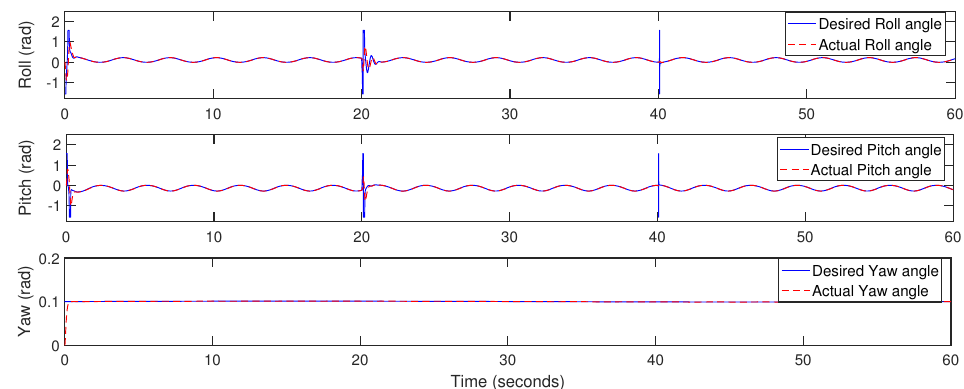
Figure 12. Attitude tracking when disturbance [sin ( 2 t ) sin ( 2 t ) sin ( 2 t ) ] applied.